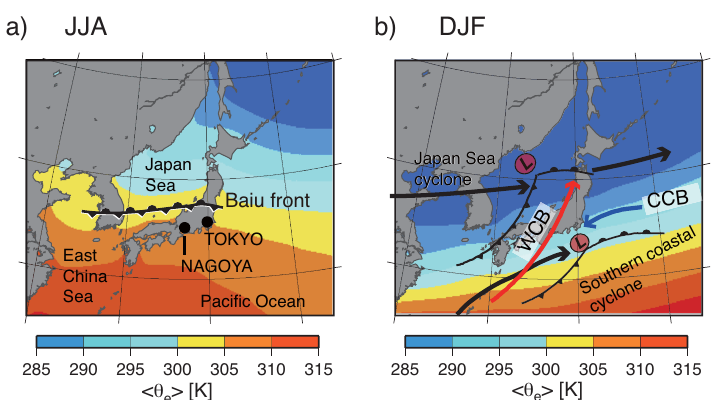
Figure 2. Seasonal mean field of vertically averaged (850–925hPa) equivalent potential temperatures (cid:104) θ e (cid:105) (shading over the oceans: K) during (a) summer (JJA) and (b) winter (DJF). The black circle represents the observation site locations (Nagoya and Tokyo). The solid black lines represent typical cyclone tracks (southern coastal cyclone and Japan Sea cyclone) over the Japan archipelago during winter. The red and blue arrows represent the warm conveyor belt (WCB), and the cold conveyor belt (CCB),